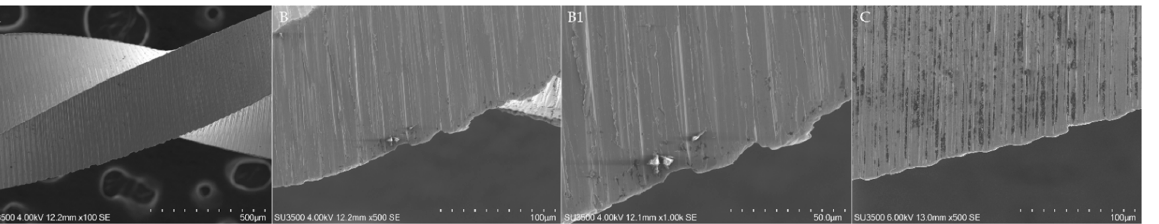
Figure 3. SEM images of debris on instruments surface. ( A , B ) EOF instruments, in which are shown several debris on the entire surface of the instrument. ( C ) OR instrument, in which are shown sporadic debris on the surface. ( D ) OR instrument, in which is shown an oily spot on the surface. All WOG instruments showed a disruption of cutting edges for their entire length, maintained also after the shaping procedures (incidence of 10) (Figure 4). Those